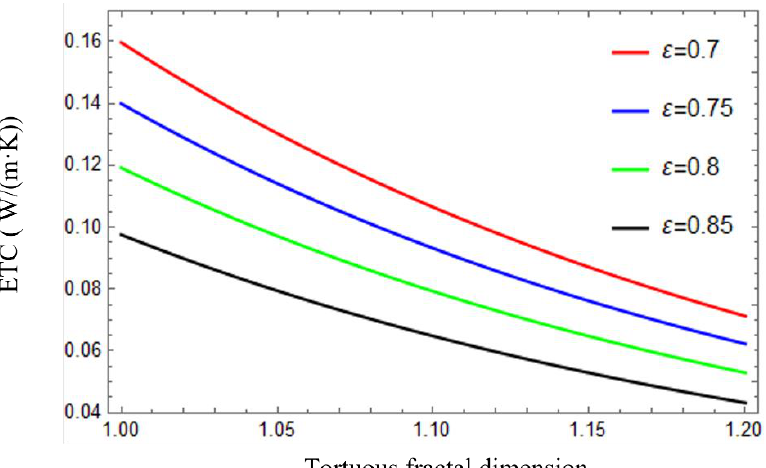
Figure 13. The variation of the ETC with the tortuous fractal dimension.